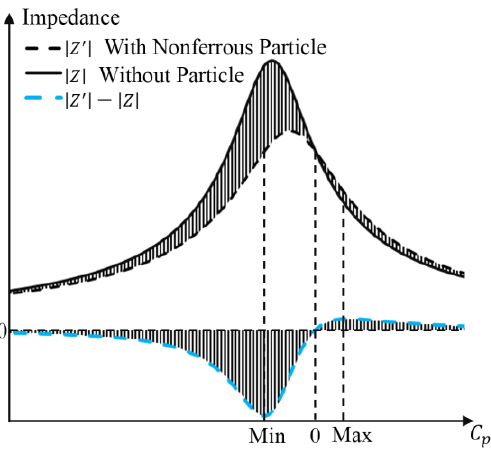
Figure 12. Schematic of impedance development with and without the nonferrous particles passing through the coil and the calculated impedance difference.